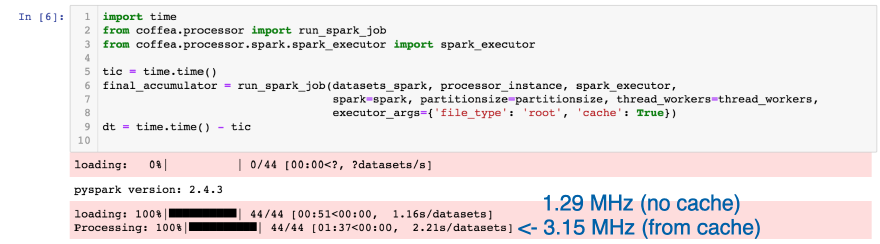
Figure 2. Evaluation of performance of Laurelin, executed in Co ff ea